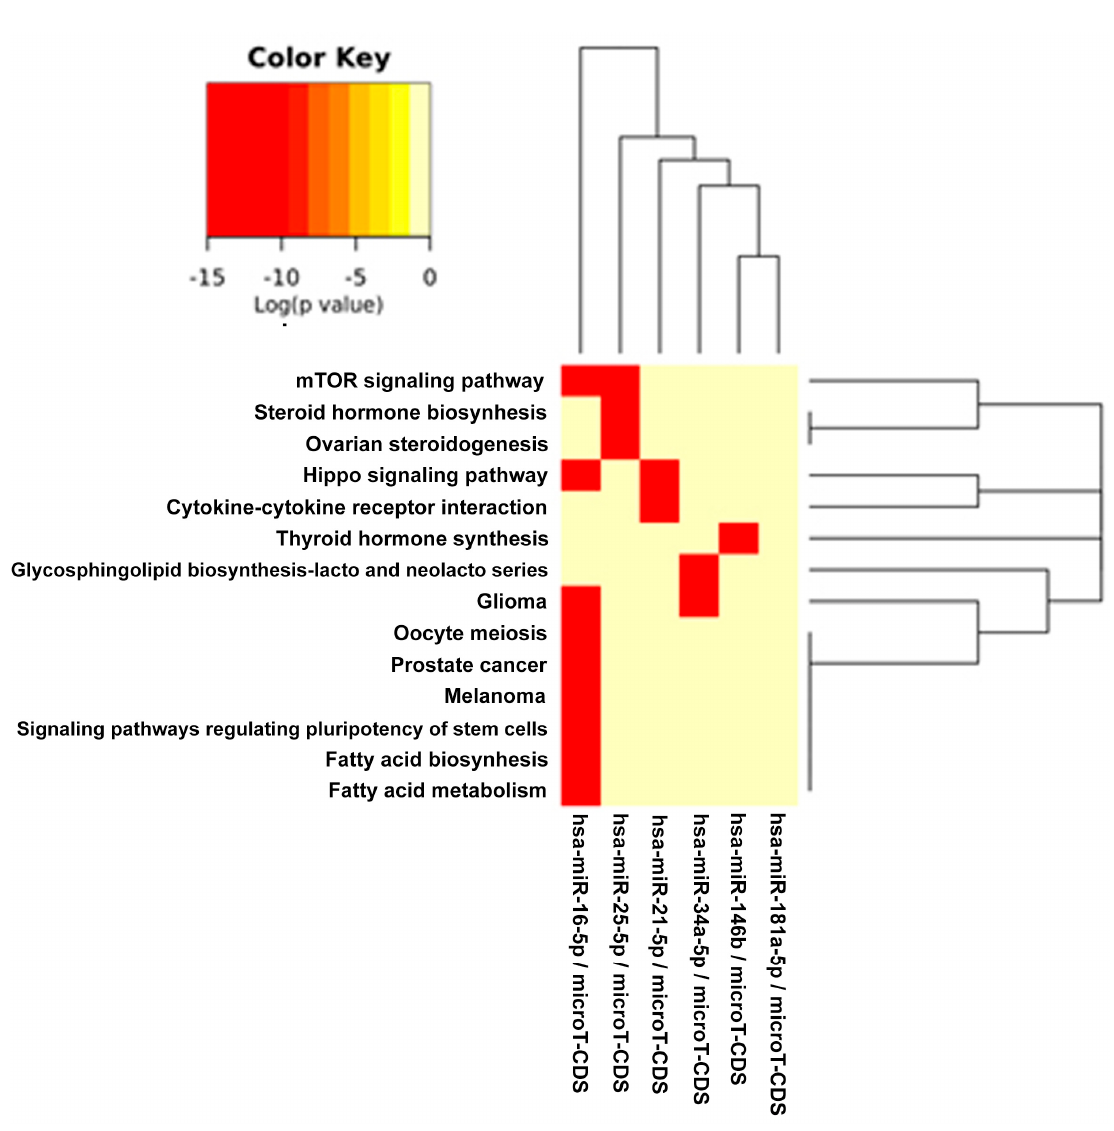
Figure 2. Binary heat map of pathways related to the common microRNAs involved in DDR signaling and modulated by all of the compounds: EGCG, CRC, RSV, n3-PUFAs. In this plot, heat map calculation is based on binary p -values (0: not targeted, 1: targeted); all significantly targeted pathways are marked with deep red. The plot shows miRNAs targeting similar pathways and pathways being targeted by